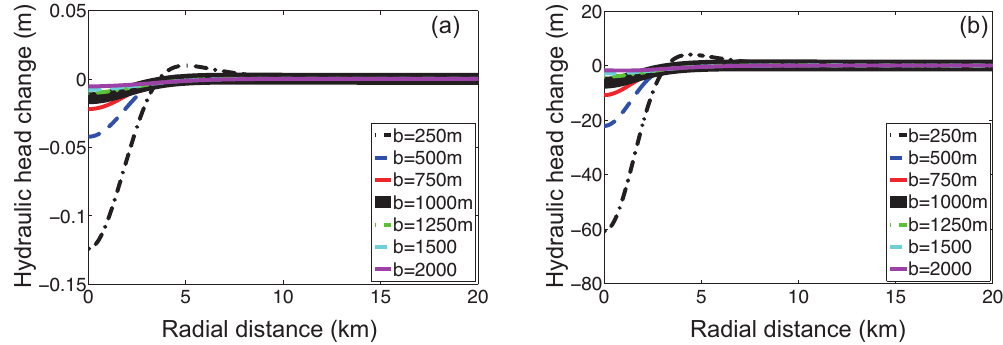
Figure 10. Influence of changing the aspect ratio of a spheroidal chamber (with constant z CH and V ) on the initial hydraulic head change profile through the aquifer. Oblate shapes have b < 1000m, prolate chambers correspond to b > 1000m. (a) pyroclastic aquifer, (b) lava flow